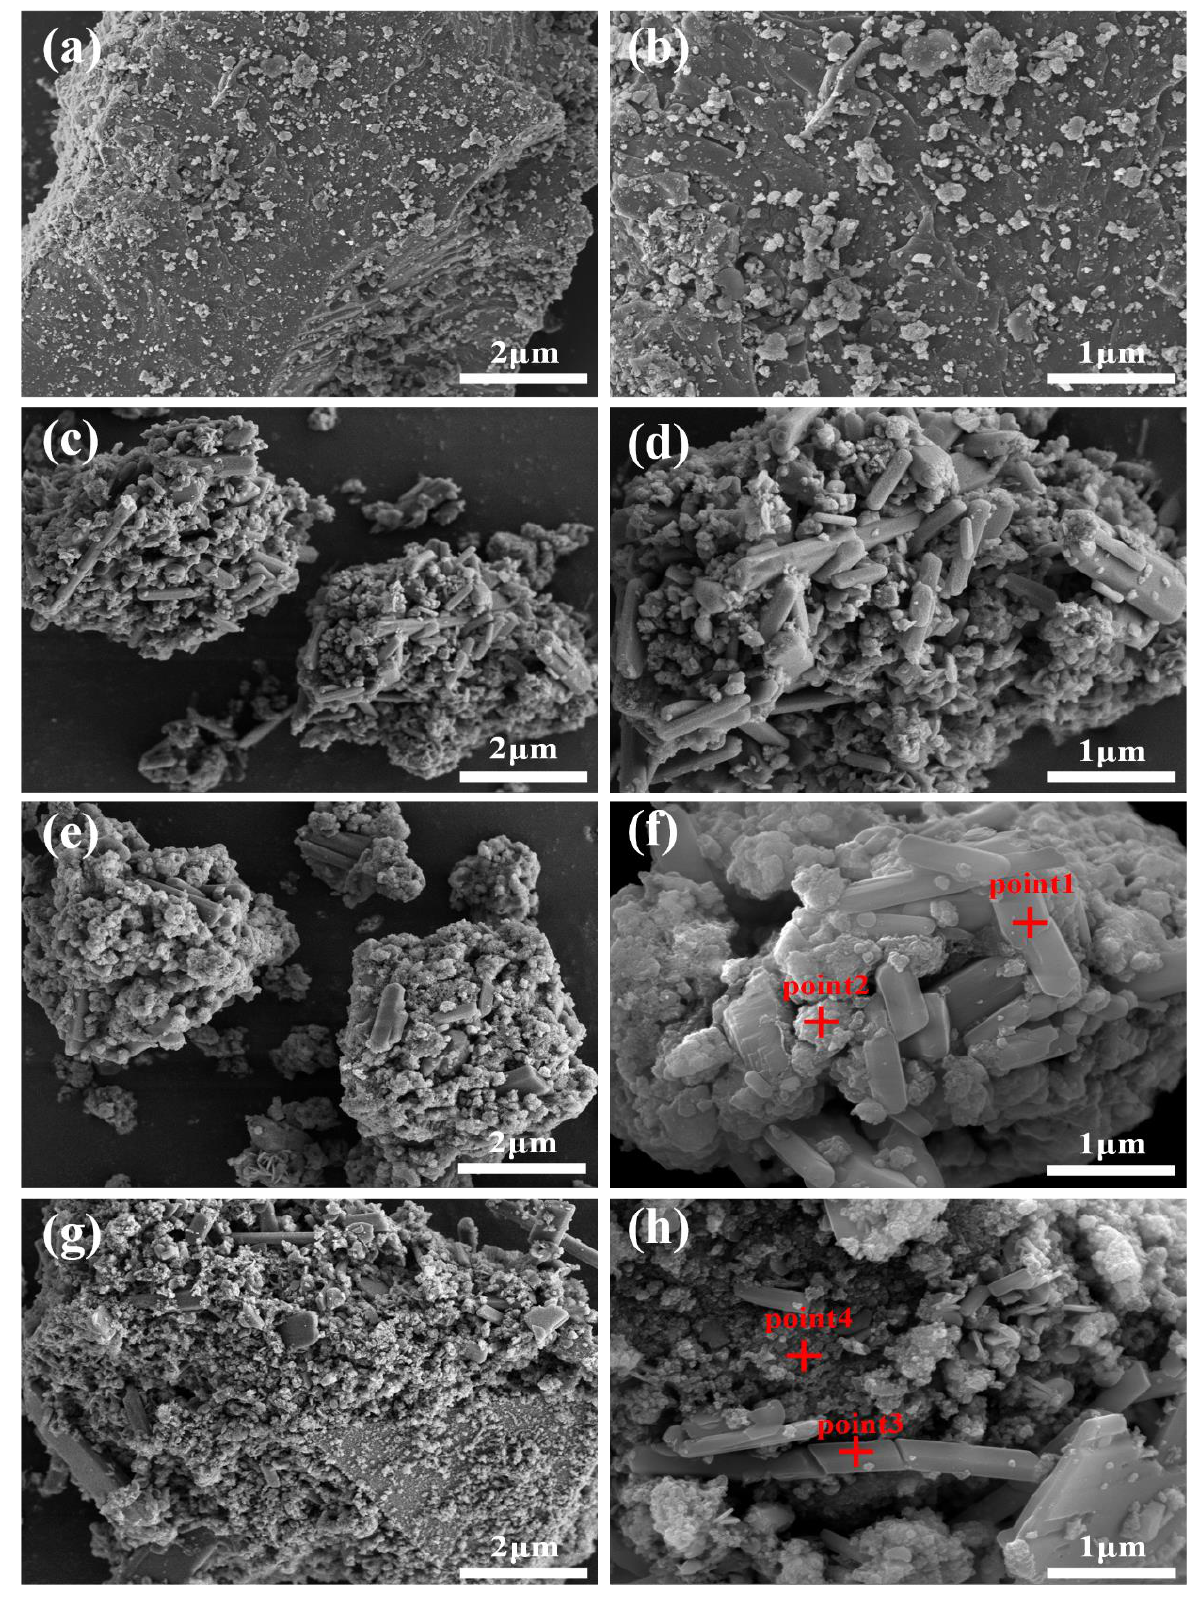
Figure 10. SEM-EDS images of original lead slag ( a , b ) and As-bearing precipitates obtained after reaction times of 1 h ( c , d ), 6 h ( e , f ), 12 h ( g , h ), at a 1:10 solid–liquid ratio, an H 2 O 2 volume ratio of 10%, and a reaction temperature of 25 ◦C.